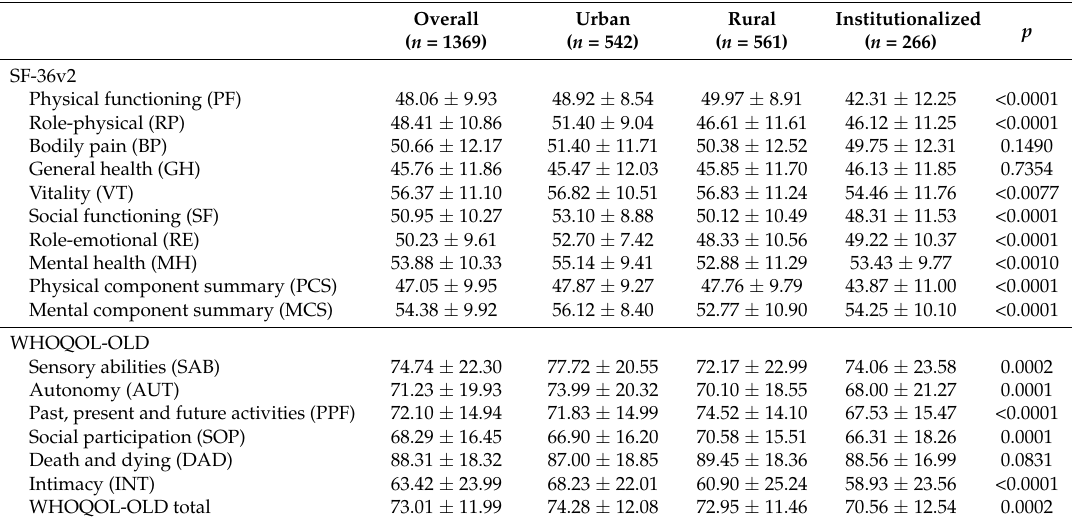
Table 2. Scores the SF-36v2 survey and WHOQOL-OLD